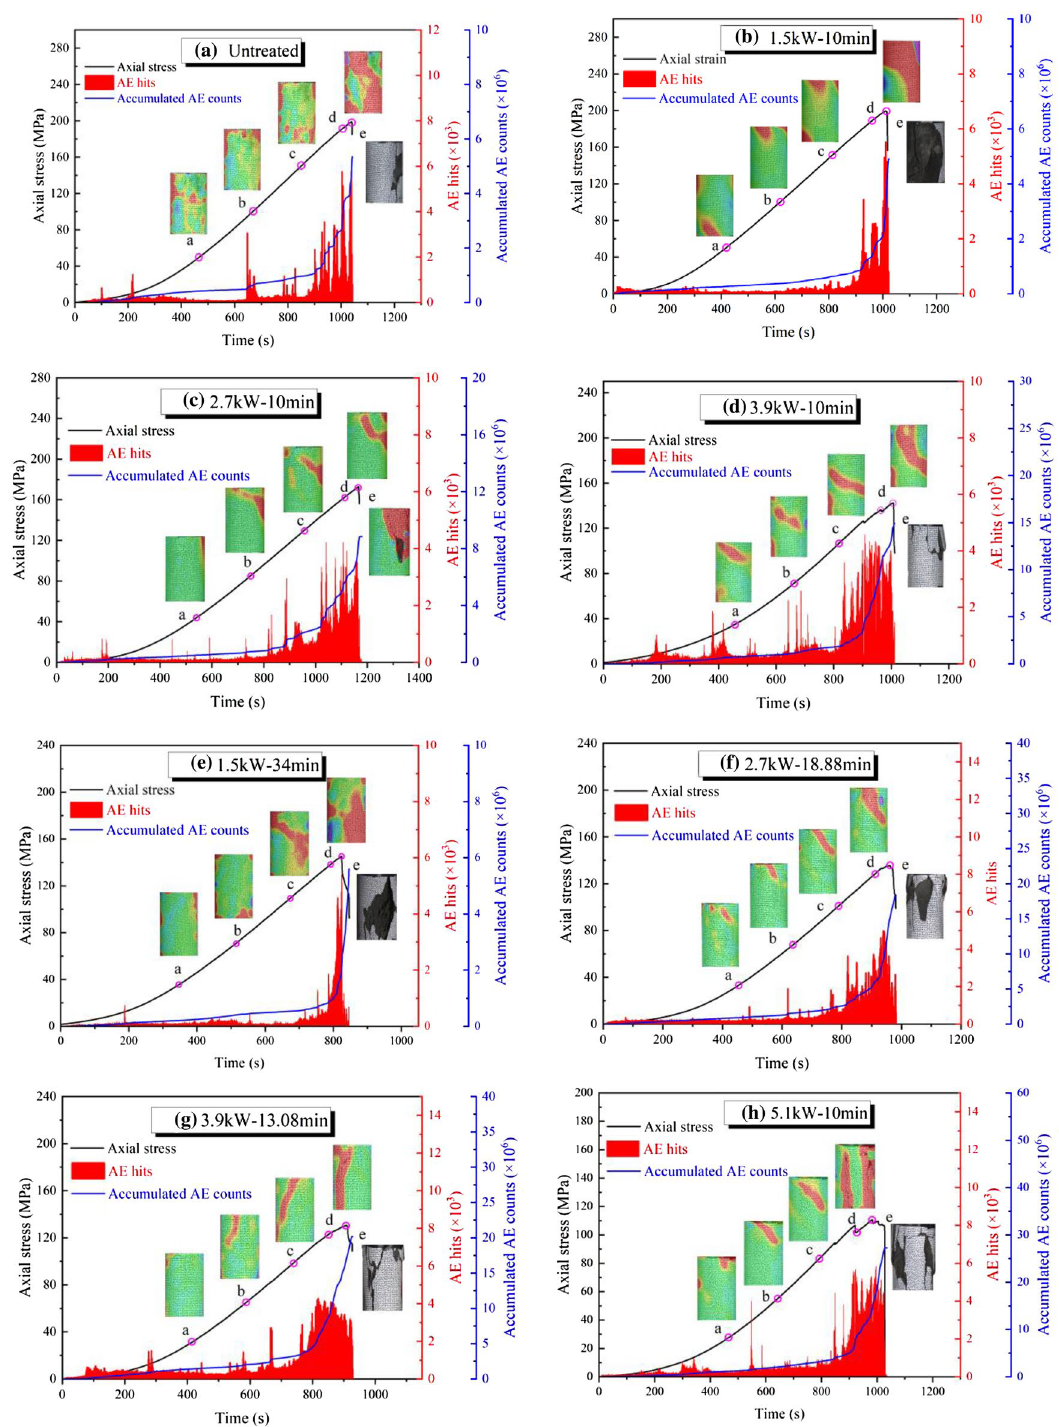
Figure 10. AE characteristics and maximum principal strain evolution of basalt samples under different exposure times and power: ( a ) Untreated; ( b ) at 1.5kW for 10 min; ( c ) at 2.7kW for 10 min; ( d ) at 3.9 kW for 10 min; ( e ) at 1.5kW for 34 min; ( f ) at 2.7 kW for 18.88 min; ( g ) at 3.9 kW for 13.08 min; ( h ) at 5.1 kW for 10